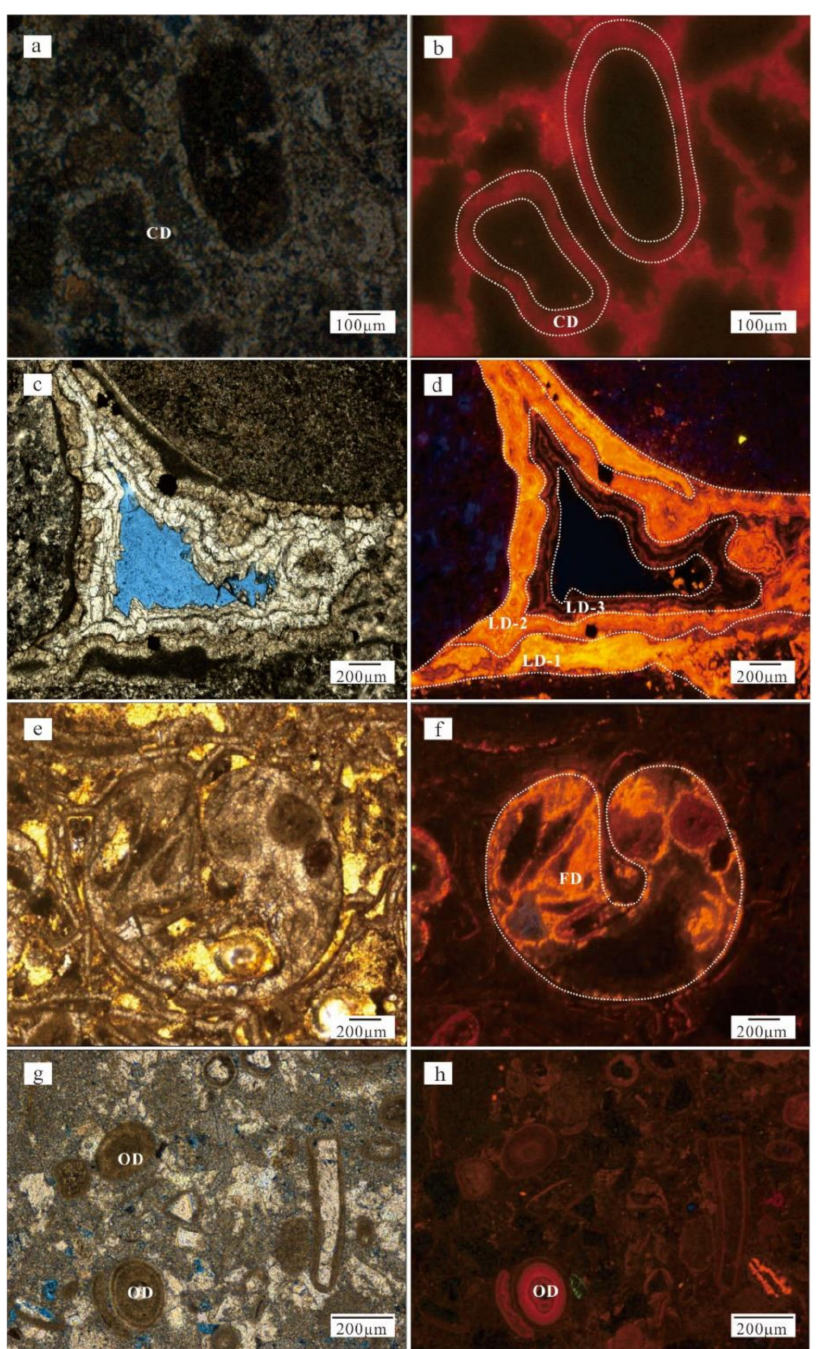
Figure 3. Cathodoluminescence (CL) images of authigenic dolomite in E 2 s: ( a ) thin isopachous microcrystalline coating dolomite (CD); ( b ) CL image of a, in which the CD exhibits faint–moderately dull red-orange red luminescence; ( c ) multigeneration interparticle pore-lining dolomite (LD) that developed in pellicular oolites; ( d ) CL image of c, in which the first-generation fine columnar dolomite exhibits bright orange luminescence (LD-1), the second-generation granular dolomite with a zonal structure exhibits bright red light (LD-2), and the third-generation granular dolomite exhibits dull red light (LD-3); ( e ) interparticle pore-filling dolomite (FD) filling a moldic cavity; and ( f ) CL image of e, in which the FD exhibits moderately bright orange luminescence; ( g ) oolitic dolomite (OD) with multiple concentric layers; and ( h ) CL image of g, in which the various cortical laminae of oolites have different degrees of